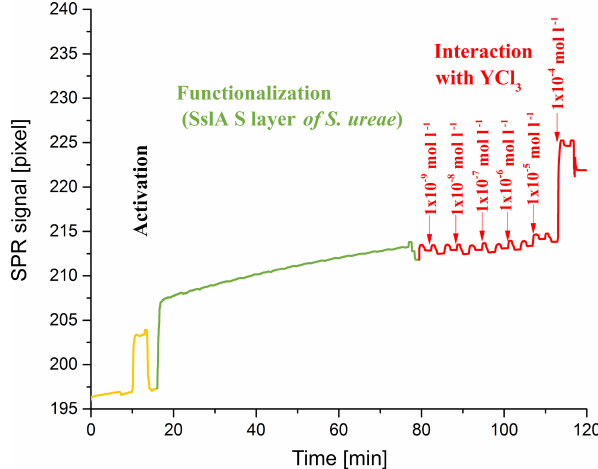
Figure 8. SPR measurement with SslA S -layer protein of S. ureae ATCC 13881 and YCl 3